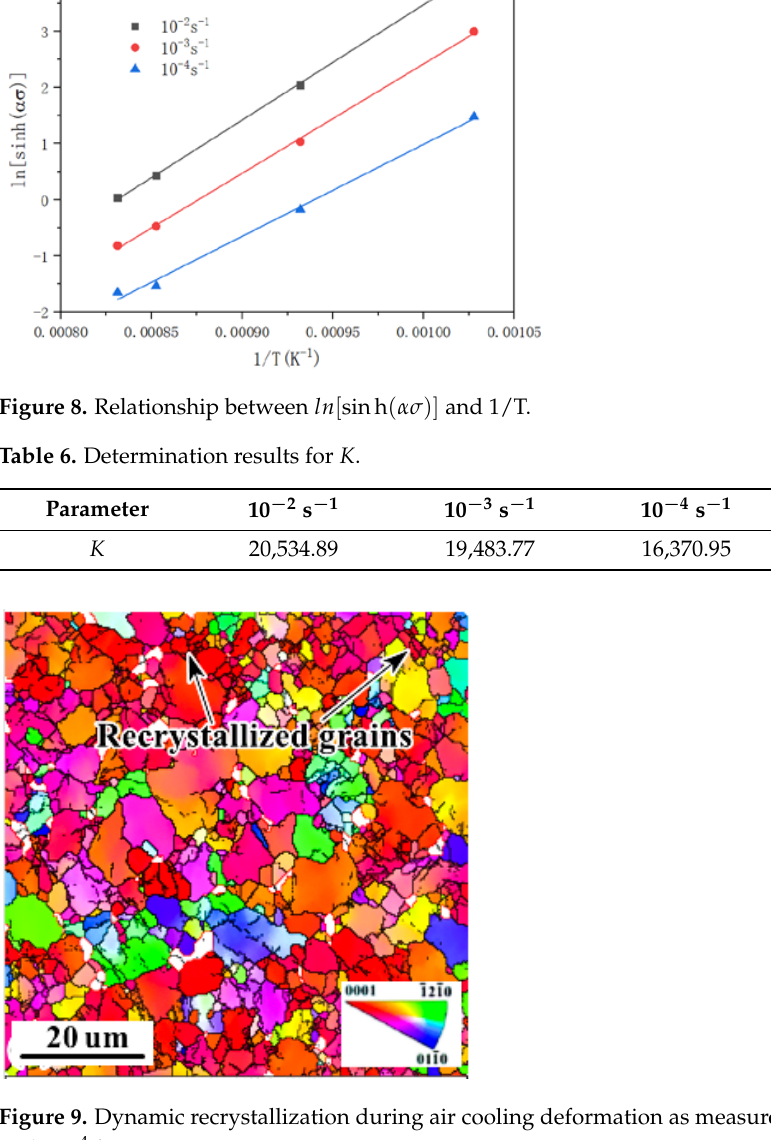
Table 7. Calculation results for lnA 3